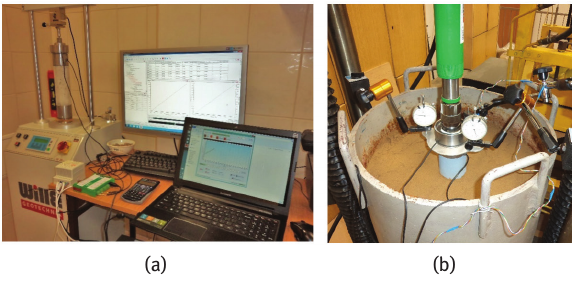
Figure 3: (a) Calibration of the model instrumented pile. (b)